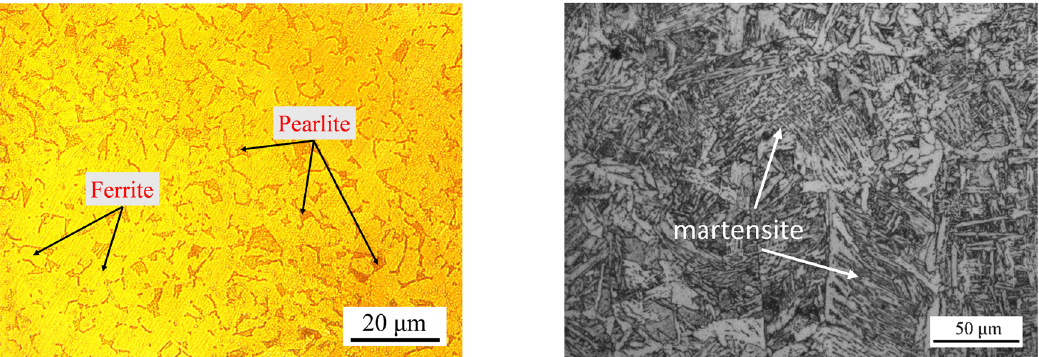
Figure 1: Microstructure of the BR1500HS ( a ) as - received and ( b ) treated with solution treatment ( ST )